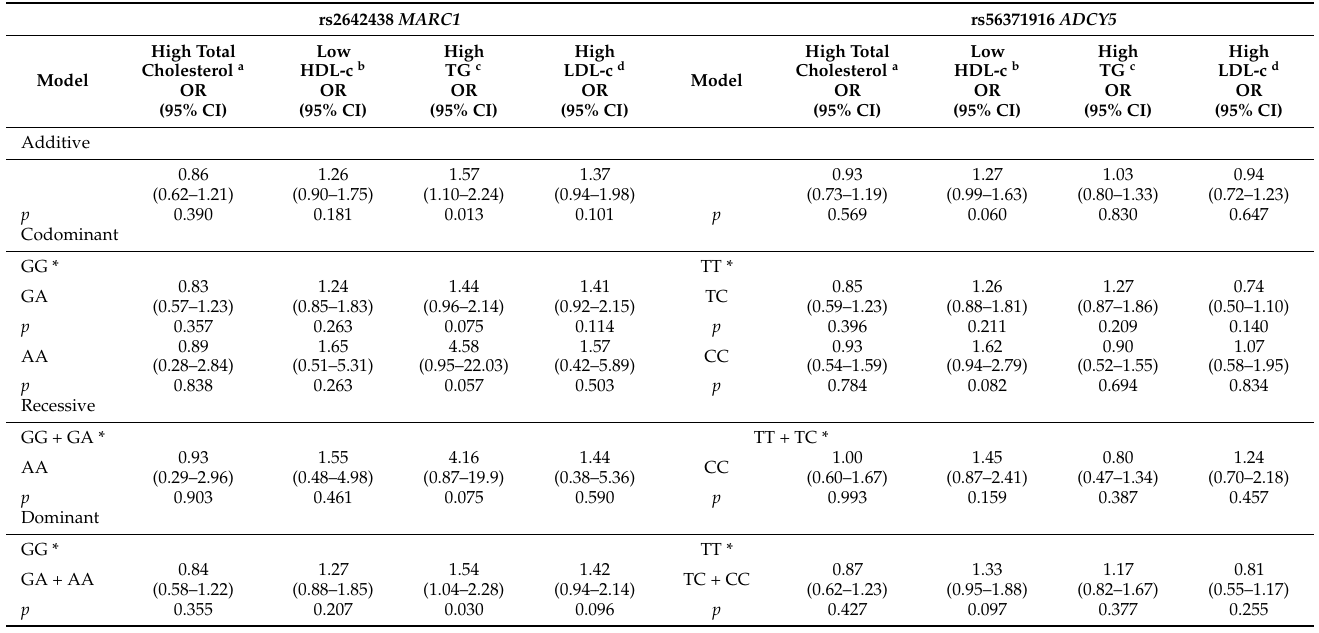
Table 2. Association between rs2642438 on MARC1 and rs56371916 on ADCY5 with lipid profile in men from